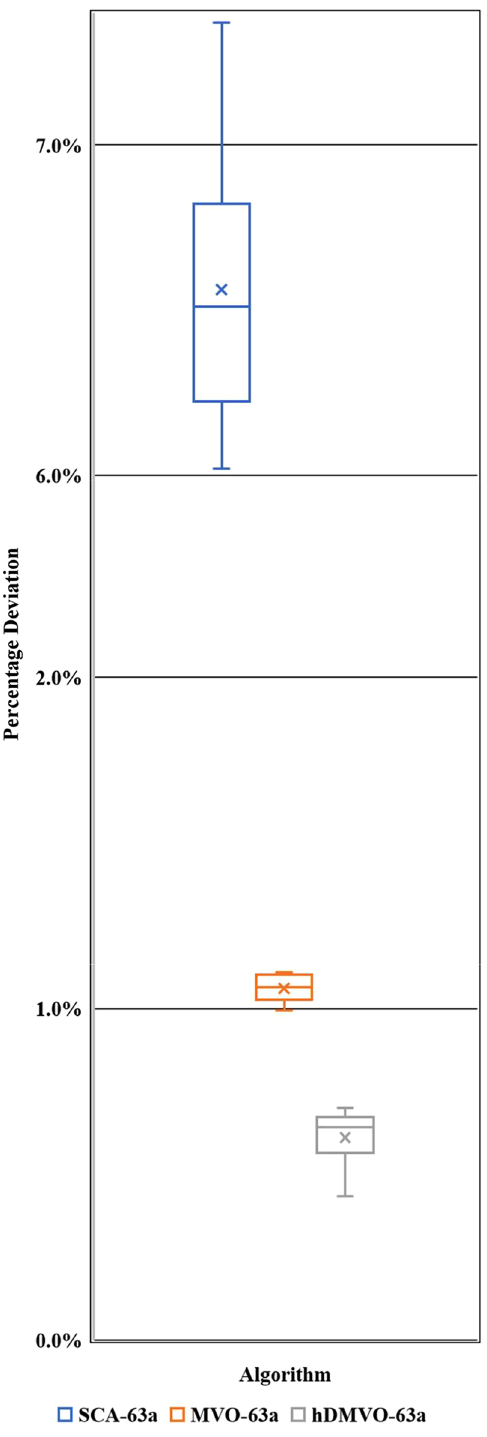
Figure 11. Percentage deviations of hDMVO, MVO and SCA in problem